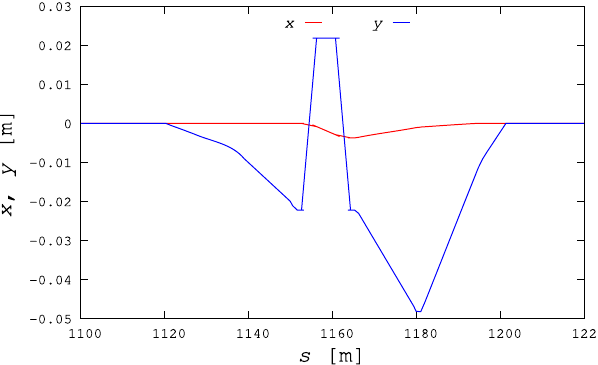
FIG. 20. Vertical local closed orbit bump in the two-helix snake region, at injection, using the helix field